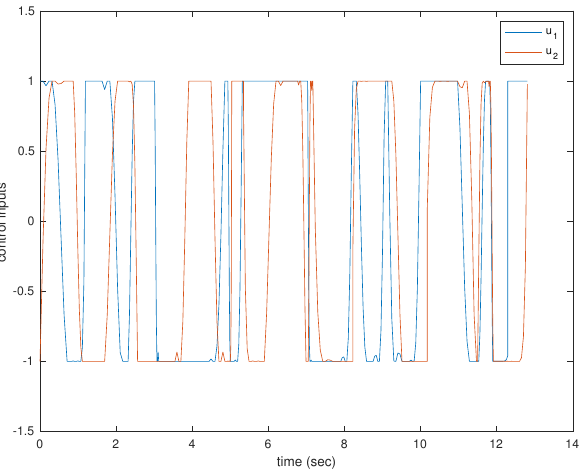
Figure 40. Acceleration components of a single agent visiting 30